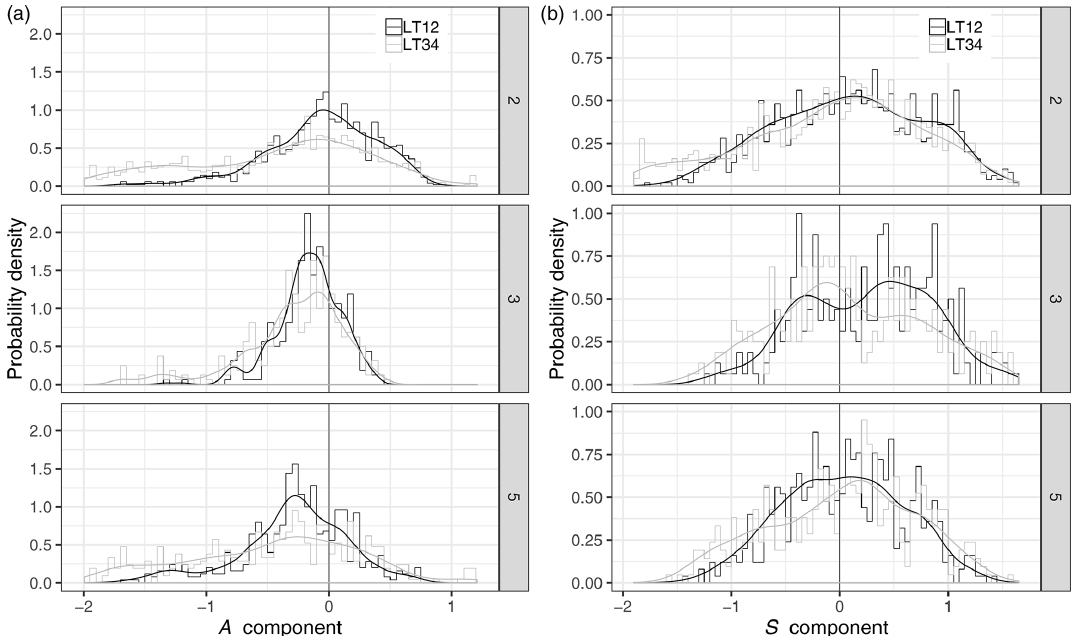
Figure 7. A -component (a) and S -component (b) normalized histograms and probability density functions for clusters 2, 3, and 5. Results for lead time LT12 are plotted as black lines, and results for lead times LT34 are in